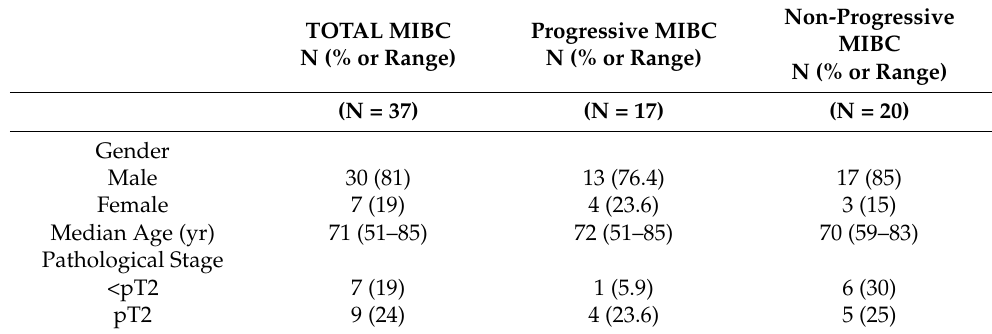
Table 1. Clinicopathological features of MIBC patients enrolled in the